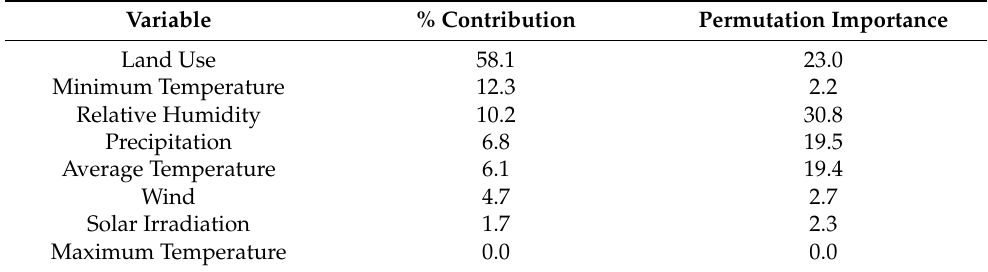
Figure 6. Graphical model map of Anoxia orientalis in Sicily. Different colors would indicate the probability of occurrence of the species on the basis of the given ensemble of predictors. Table 4. Relative importance of the various factors associated with the presence points in a MAXENT modelling on the potential distribution of Anoxia orientalis in